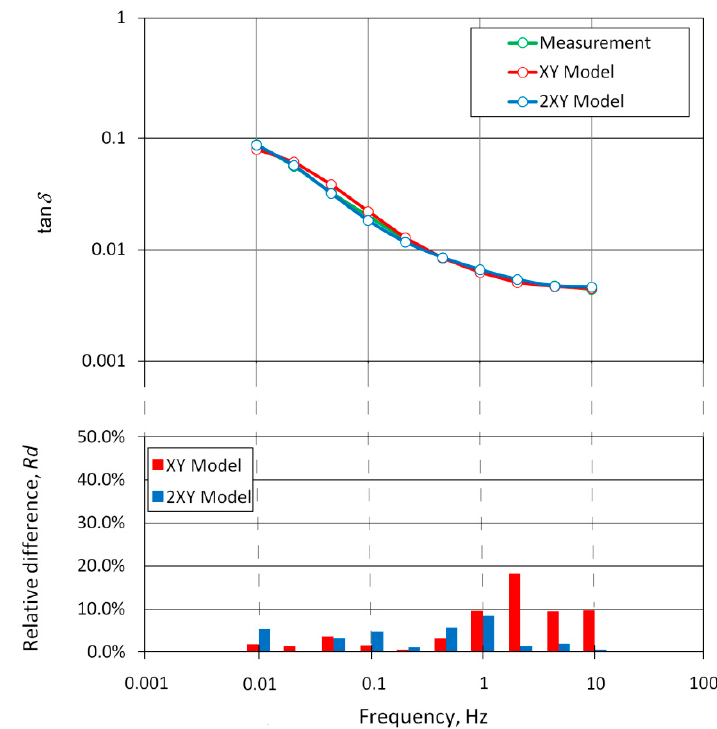
Figure 14. The dependence of the loss tangent on the frequency, measured for the OS type ( U n = 110 kV) bushing insulator and calculated based on the XY and 2 XY models, with the calculated relative differences between the measured and calculated values for both models.